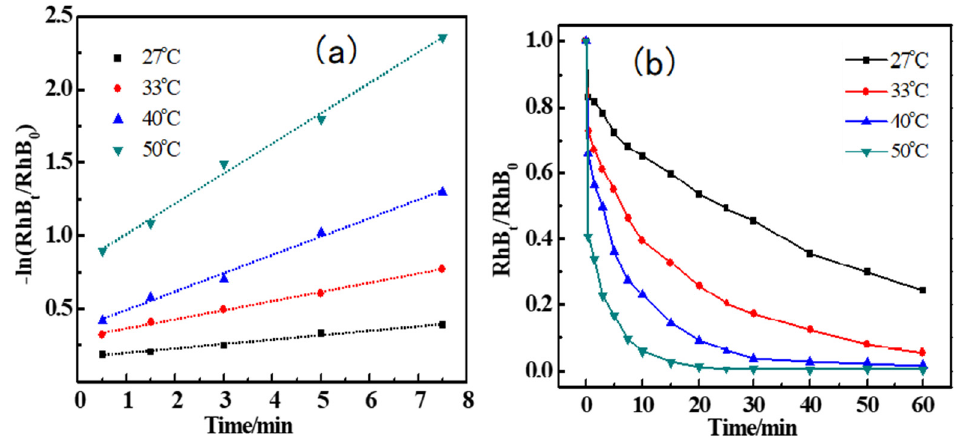
Figure 8. Catalytic degradation of RhB under different reaction temperatures ( a ) plots of pseudo-first-order kinetics; ( b ) RhB concentration.